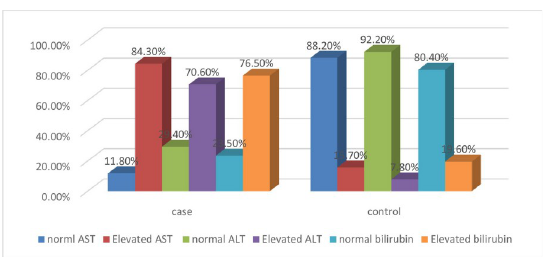
Fig 1. Categorical value of AST, ALT and total serum bilirubin among the study participants.